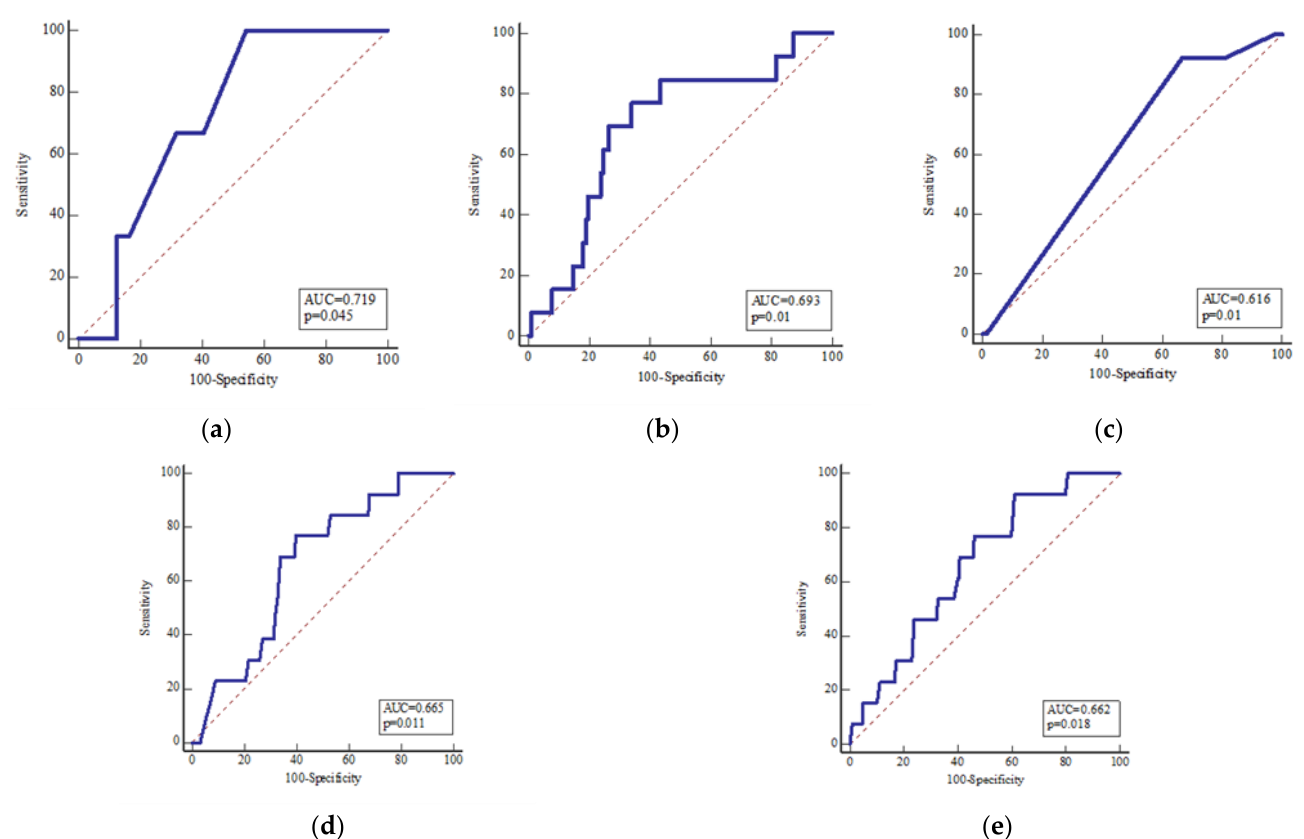
Figure 3. The value of meteorological and clinical parameters in predicting potential complications, ROC analysis: ( a ) number of days from intervention to hospitalization (area under curve, AUC = 0.72; p = 0.04, sensitivity, SE = 100%, specificity, SP = 45.6%), ( b ) CRP levels increase (AUC = 0.69; p = 0.01, SE = 76.9%, SP = 66.1%), ( c ) type of therapy of OA (AUC = 0.62; p = 0.01, SE = 92.3%, SP = 33.2%), ( d ) change of atmospheric pressure two days prior to hospitalization (AUC = 0.66; p = 0.01, SE = 76.9%, SP = 60.3%), and ( e ) change of atmospheric pressure five days prior to hospitalization (AUC = 0.66; p = 0.01, SE = 92.3%, SP = 39.0%) present moderate to strong indicators for potential complications.